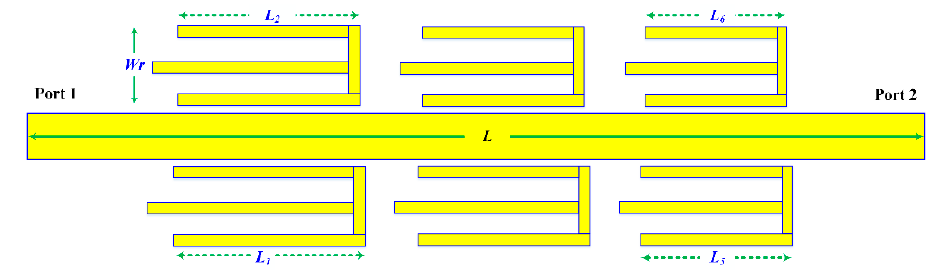
Figure 7. Six quad-state resonators.